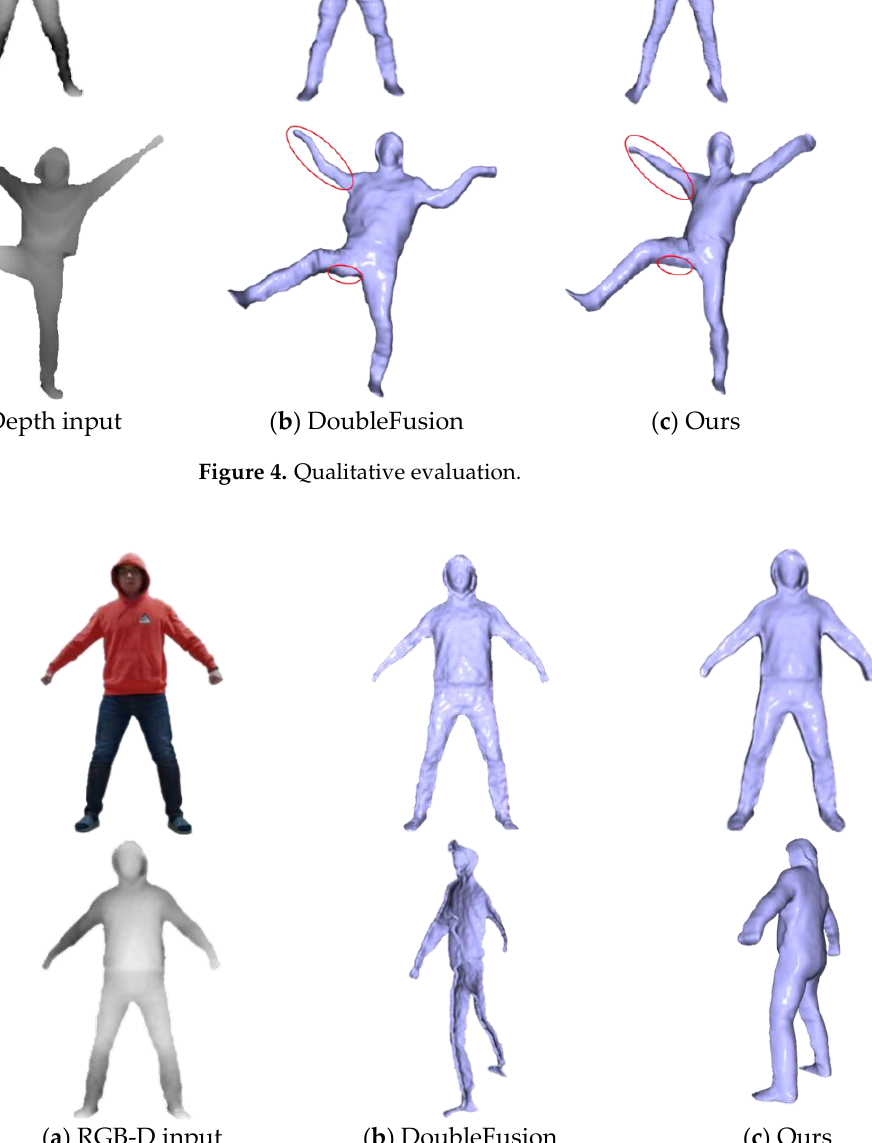
Figure 4. Qualitative evaluation.